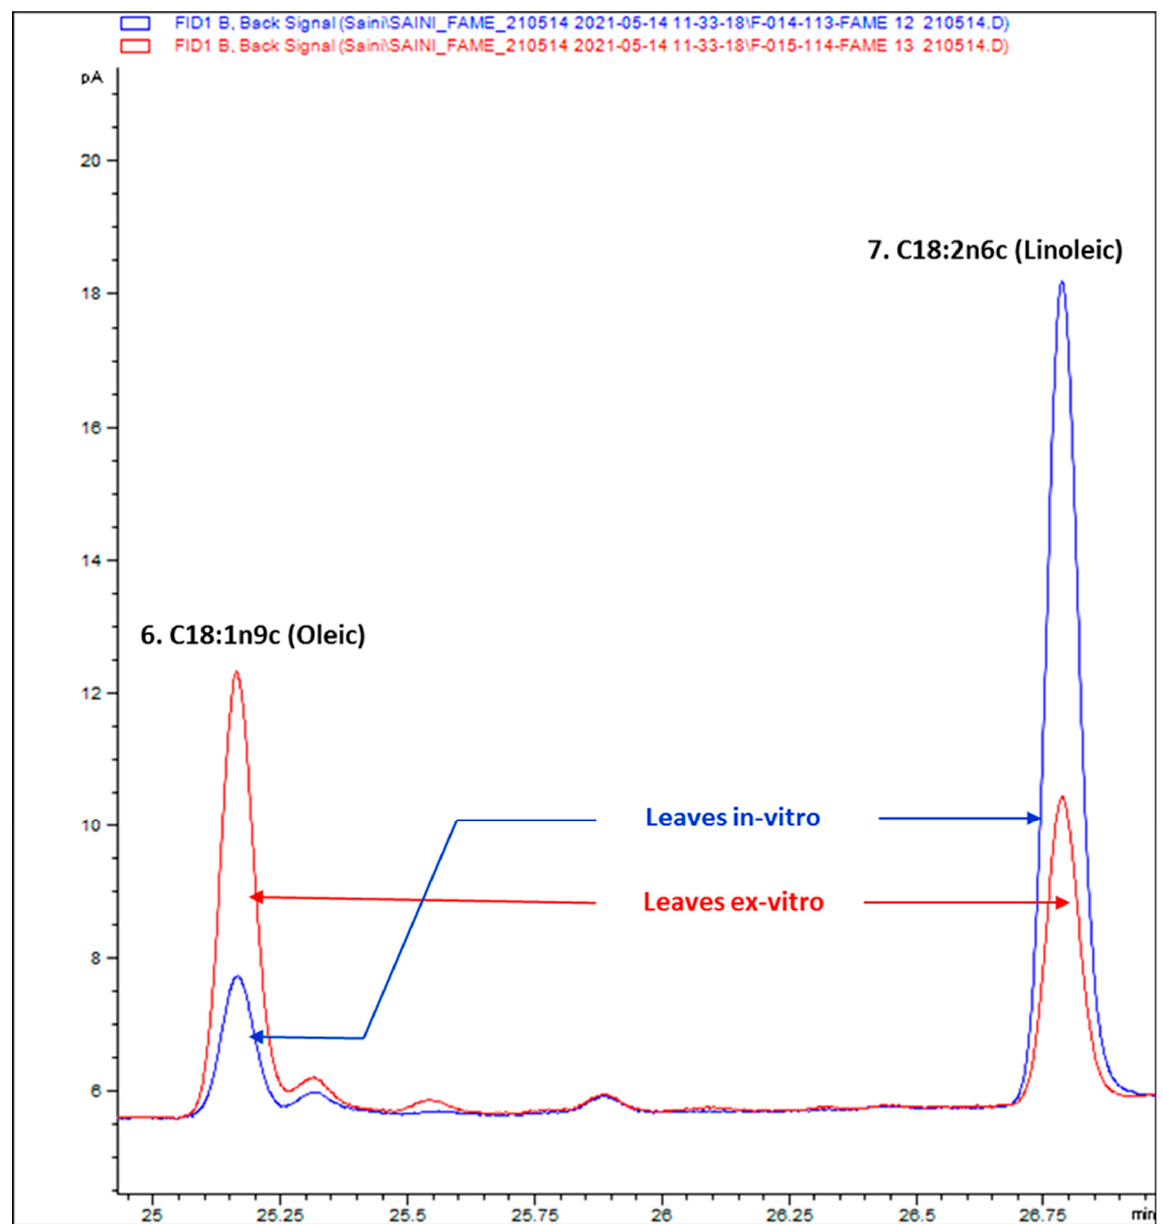
Figure 6. Comparison of oleic: linoleic acid peaks.